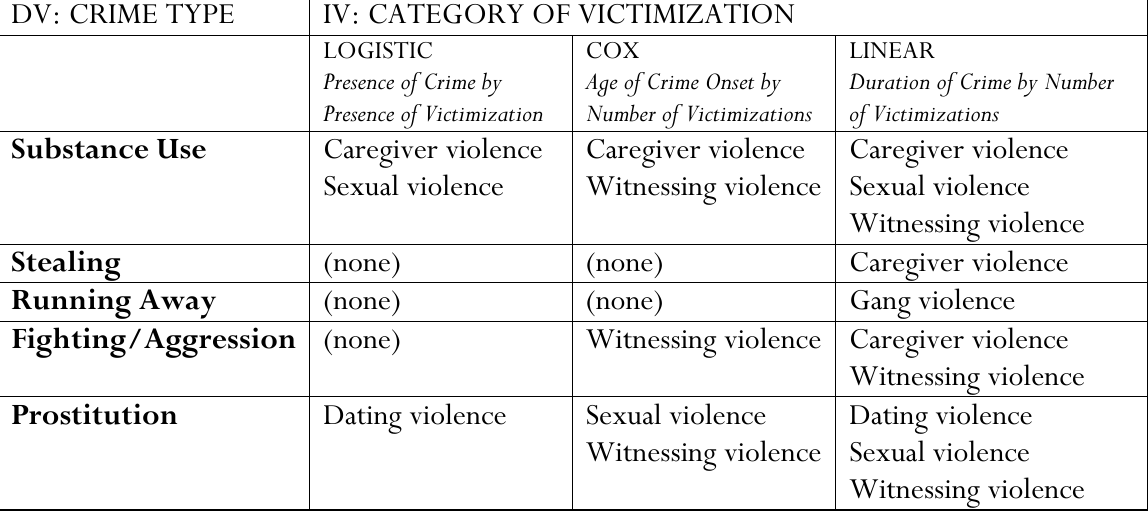
Table 20: Significant Predictors of Crime across Three Types of Regression Analyses DV: CRIME